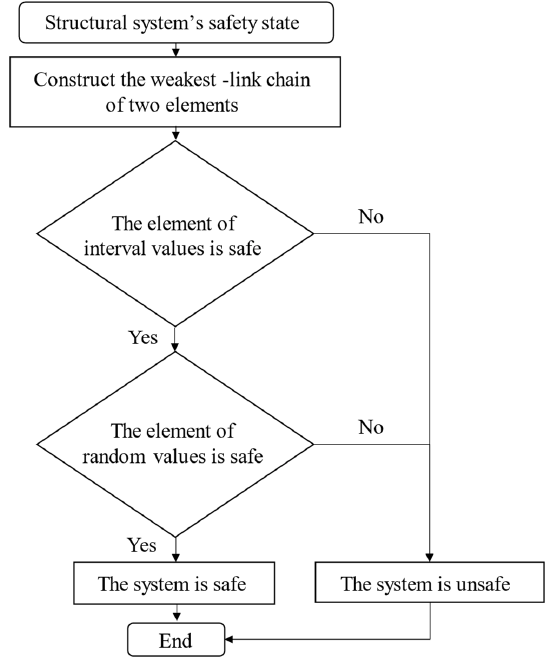
Figure 2. Flowchart of safety state determination. Table 1. Estimation of structural reliability.